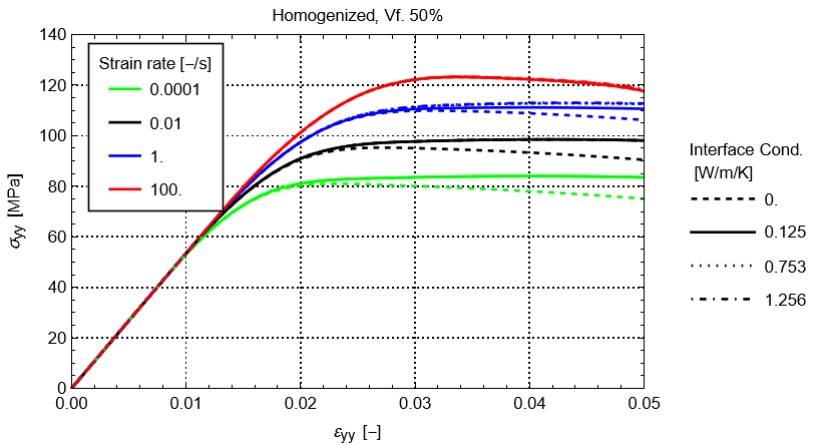
Figure 10. Effect of fiber-matrix interface conductivity on homogenized stress-strain at multiple strain rates for a volume fraction of 50%.